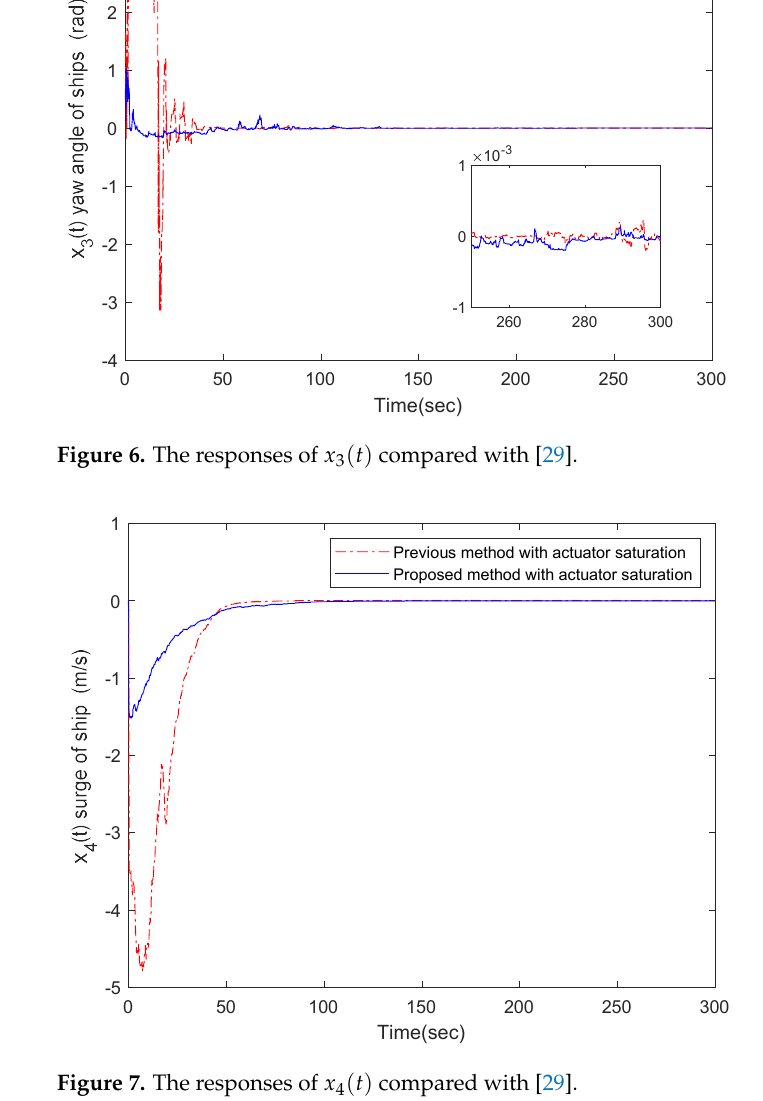
Figure 7. The responses of  